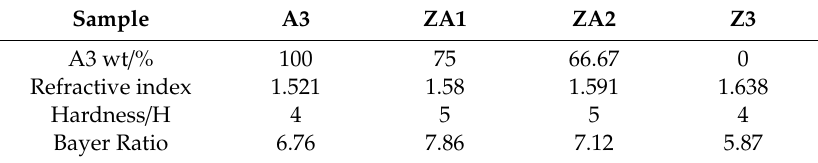
Table 5. Refractive index, hardness, and Bayer ratio of composite coatings with di ff erent A3 content.